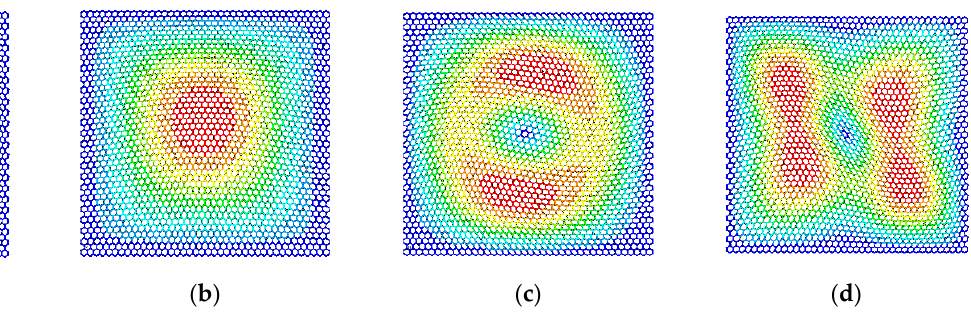
Figure 9. The vibration modes of graphene with the length of the carbon covalent bonds equal to 0.1 nm (( a – d ) represent the first four resonant vibration modes).